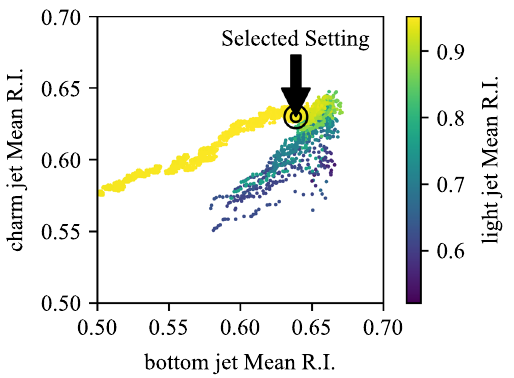
Fig. 12 AVR parameter scan